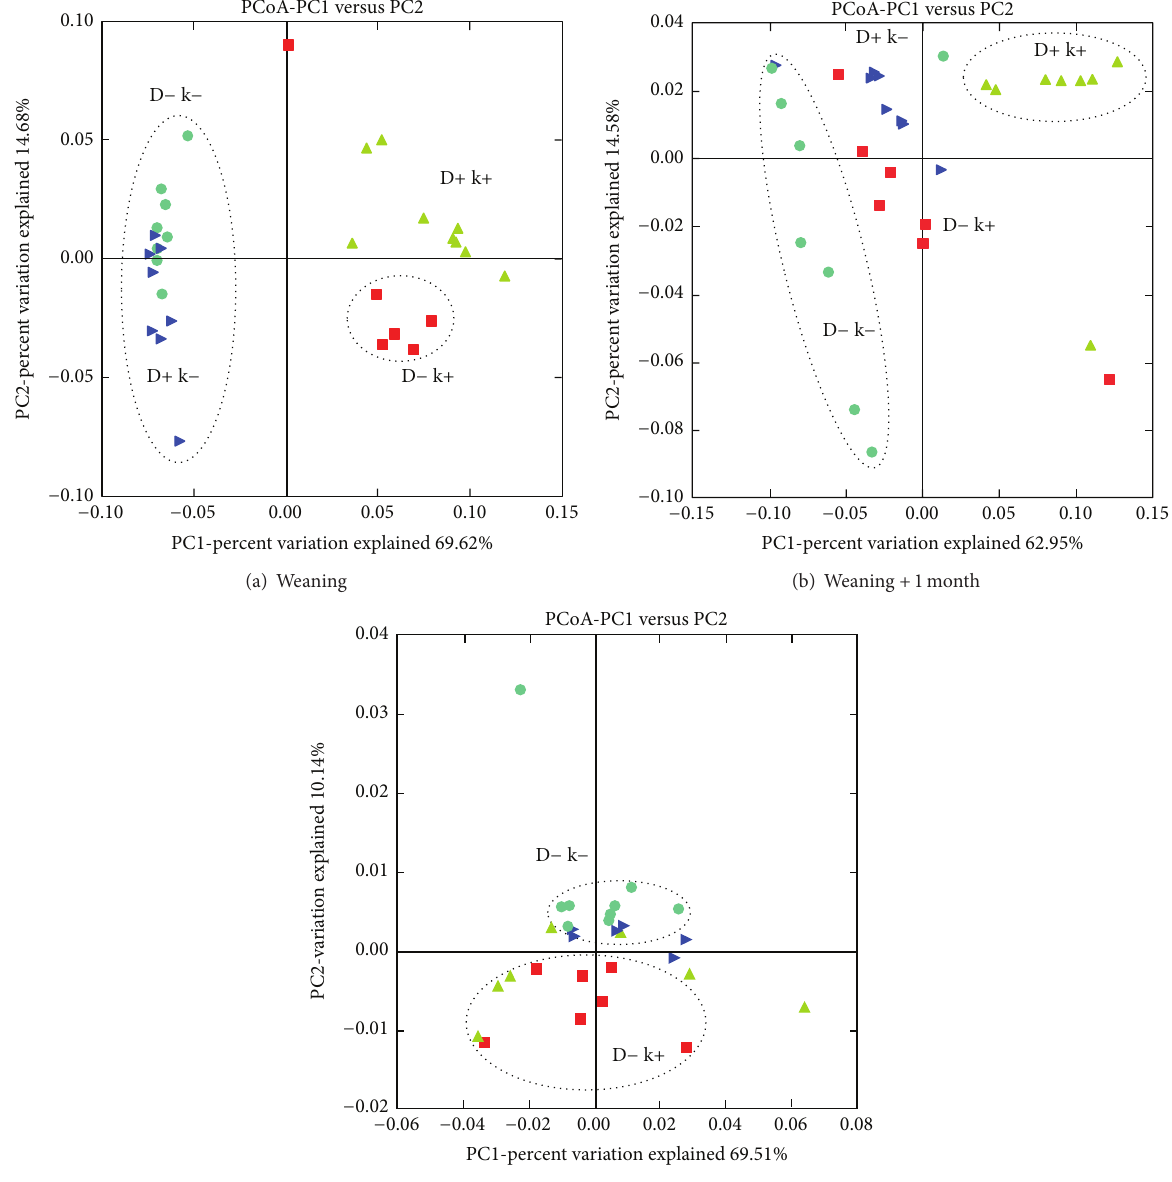
Figure 3: Principal component analysis of rumen methanogenic archaea profiles at (a) weaning, (b) 1month after, and (c) 4 months after weaning. Experimental groups: up-pointing pale green triangle = D+ k+, right-pointing blue triangle = D+ k − , green circles = D − k − , and red square = D − k+. D+ k+ = treated kids from treated does; D+ k − = untreated kids from treated does; D − k+ = treated kids from untreated does; D − k − = untreated kids from untreated